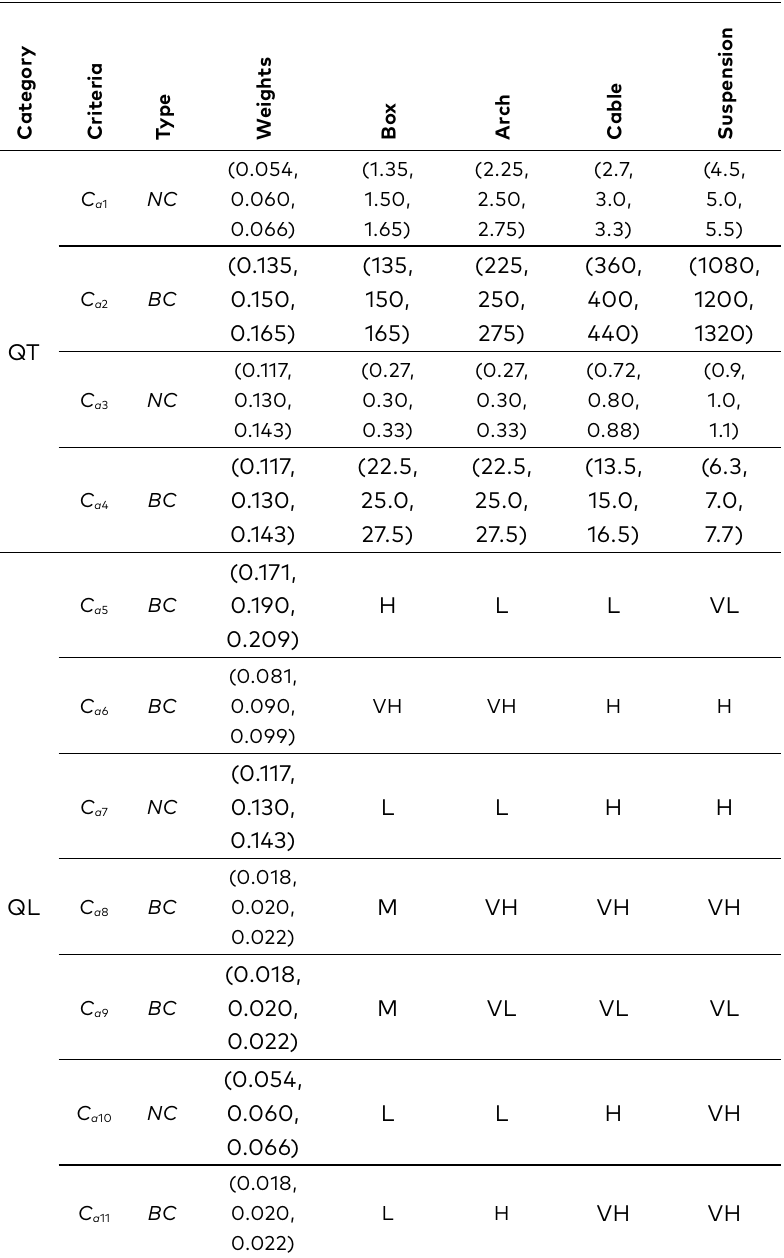
Table 3. The decision-matrix of the Structural Systems